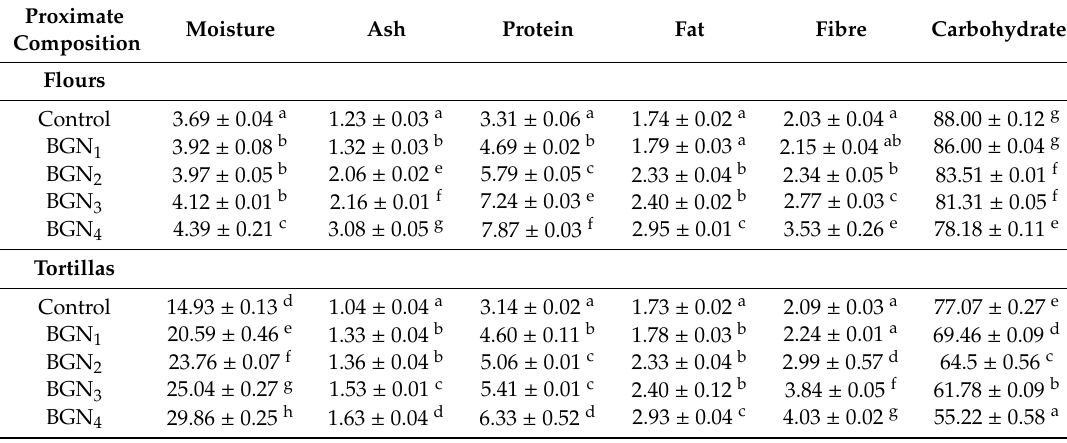
Table 2. Proximate compositions of composite flours and tortillas per 100 g (dry